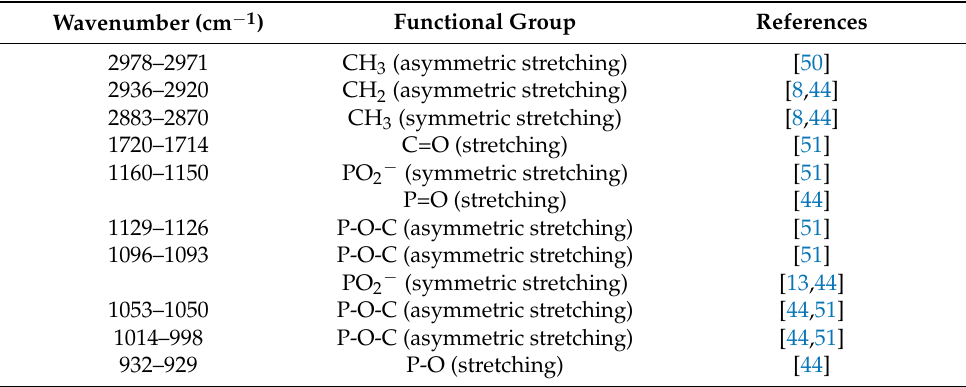
Table 2. Wavenumbers of the 10 peaks distinguished in 3012–2851, 1854–1611 and 1192–909 cm − 1 spectral regions of cheese water-soluble extracts could be attributed to the functional groups of